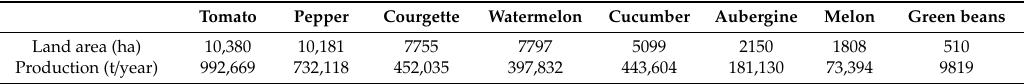
Table 1. Land area and production of the main crops in the province of Almeria in the year 2018.